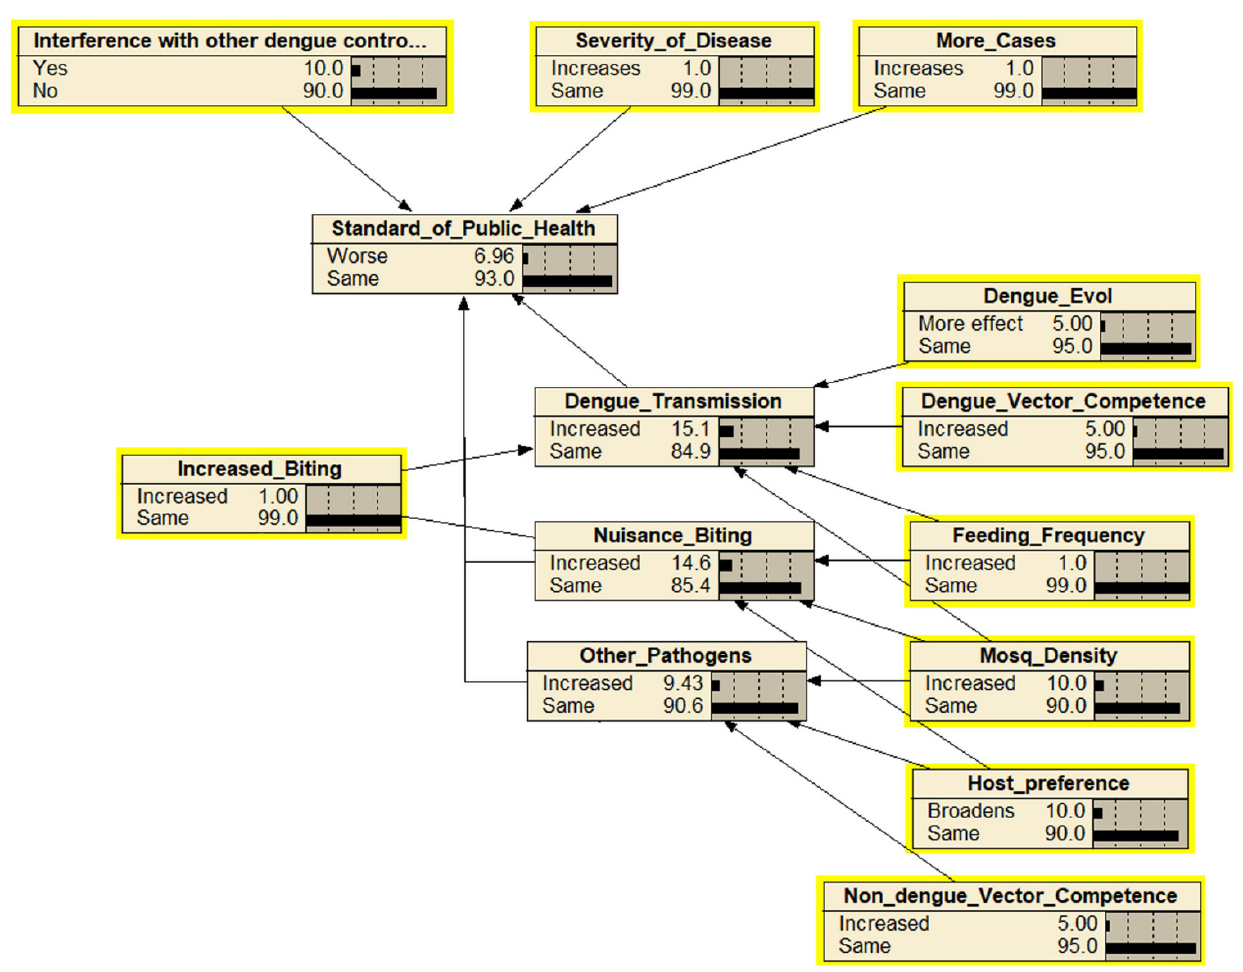
Figure 5. The Bayesian belief network for the endpoint “standard of public health”. Each node (box) represents the probability of hazards that might occur within the next 30 years as the result of the release of Wolbachia -infected Ae. aegypti . Parent nodes are in the yellow boxes.